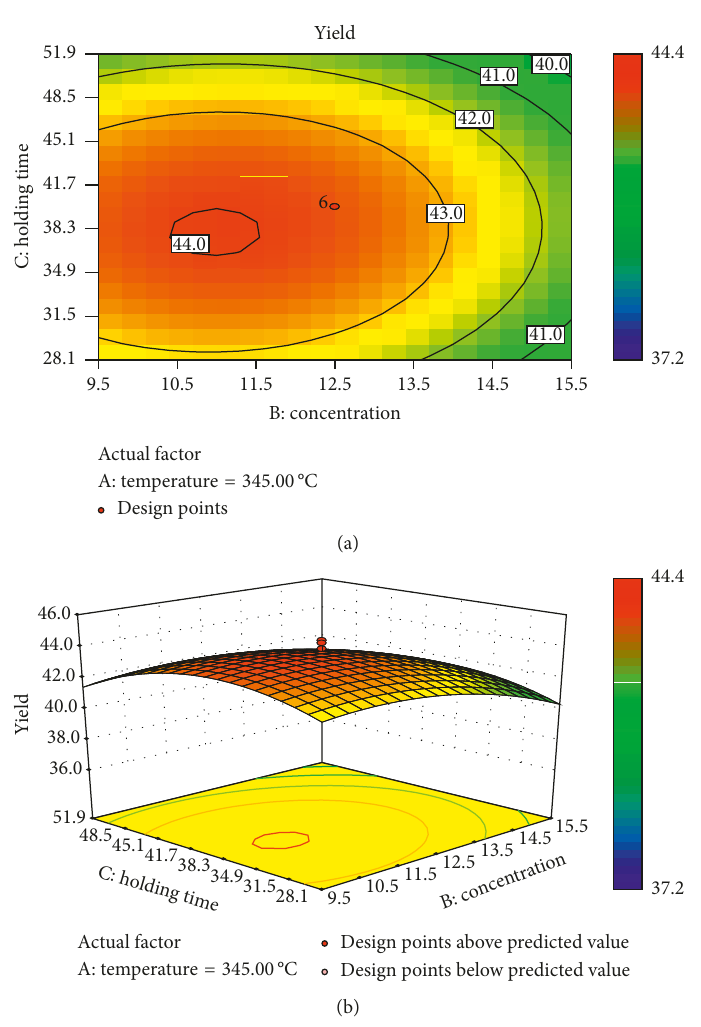
Figure 5: Contour plot and response surface plot of biocrude yield as function of holding time and concentration.